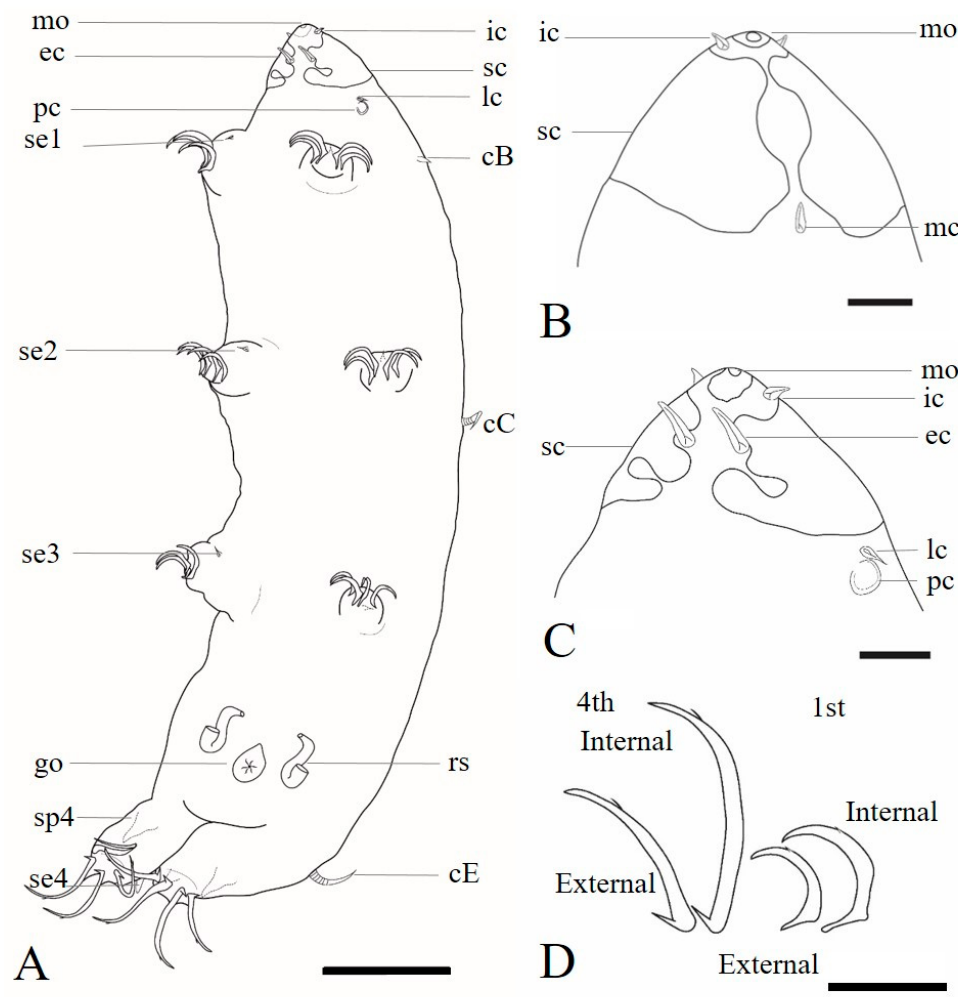
Figure 2. Coronarctus dissimilis sp. nov. Drawings based on the holotype. ( A ) Ventral view of the body; ( B ) Dorsal view of the head; ( C ) Ventral view of the head; ( D ) Claws of the first and fourth pairs of legs. Abbreviations: cB—cirrus B , cC—cirrus C ; cE—cirrus E ; ec—external cirrus; go—gonopore; ic—internal cirrus; lc—lateral cirrus A ; mc—median cirrus; mo—mouth; pc—primary clava; rs—seminal receptacle; sc—secondary clava; se1–4—sensory organ legs I–IV; sp4—coxal process on leg IV. Scale bars: A-50 µm, B–D-10 µm.